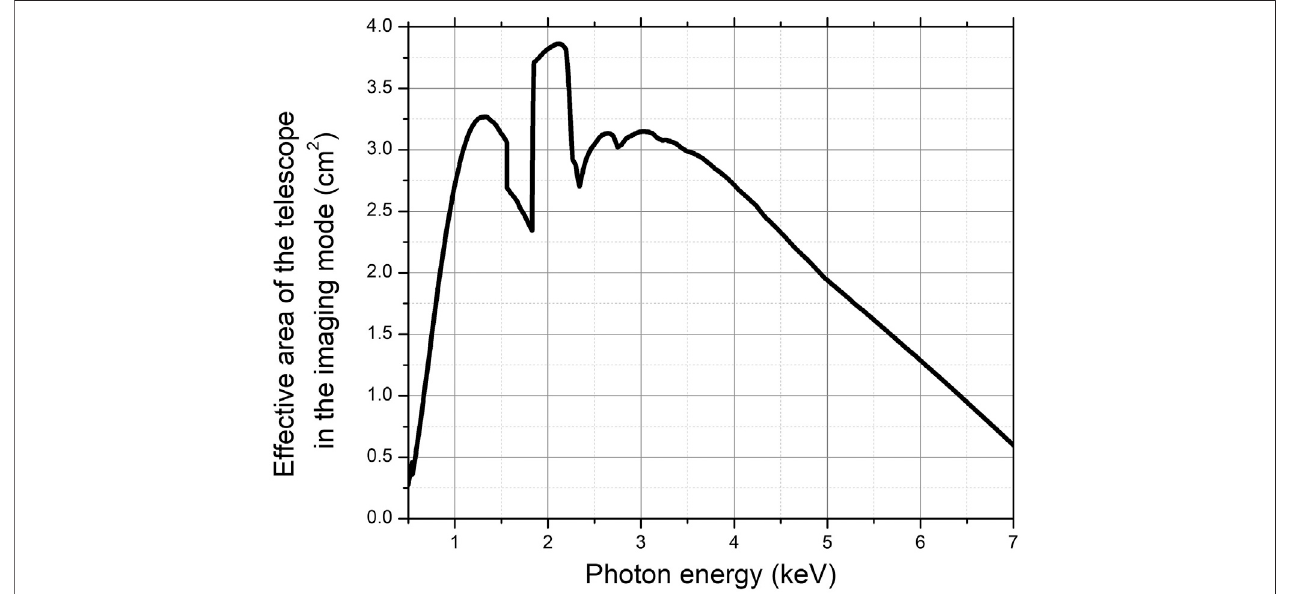
FIGURE 7 | Effective area of the instrument in the imaging mode as a function of the photon energy.